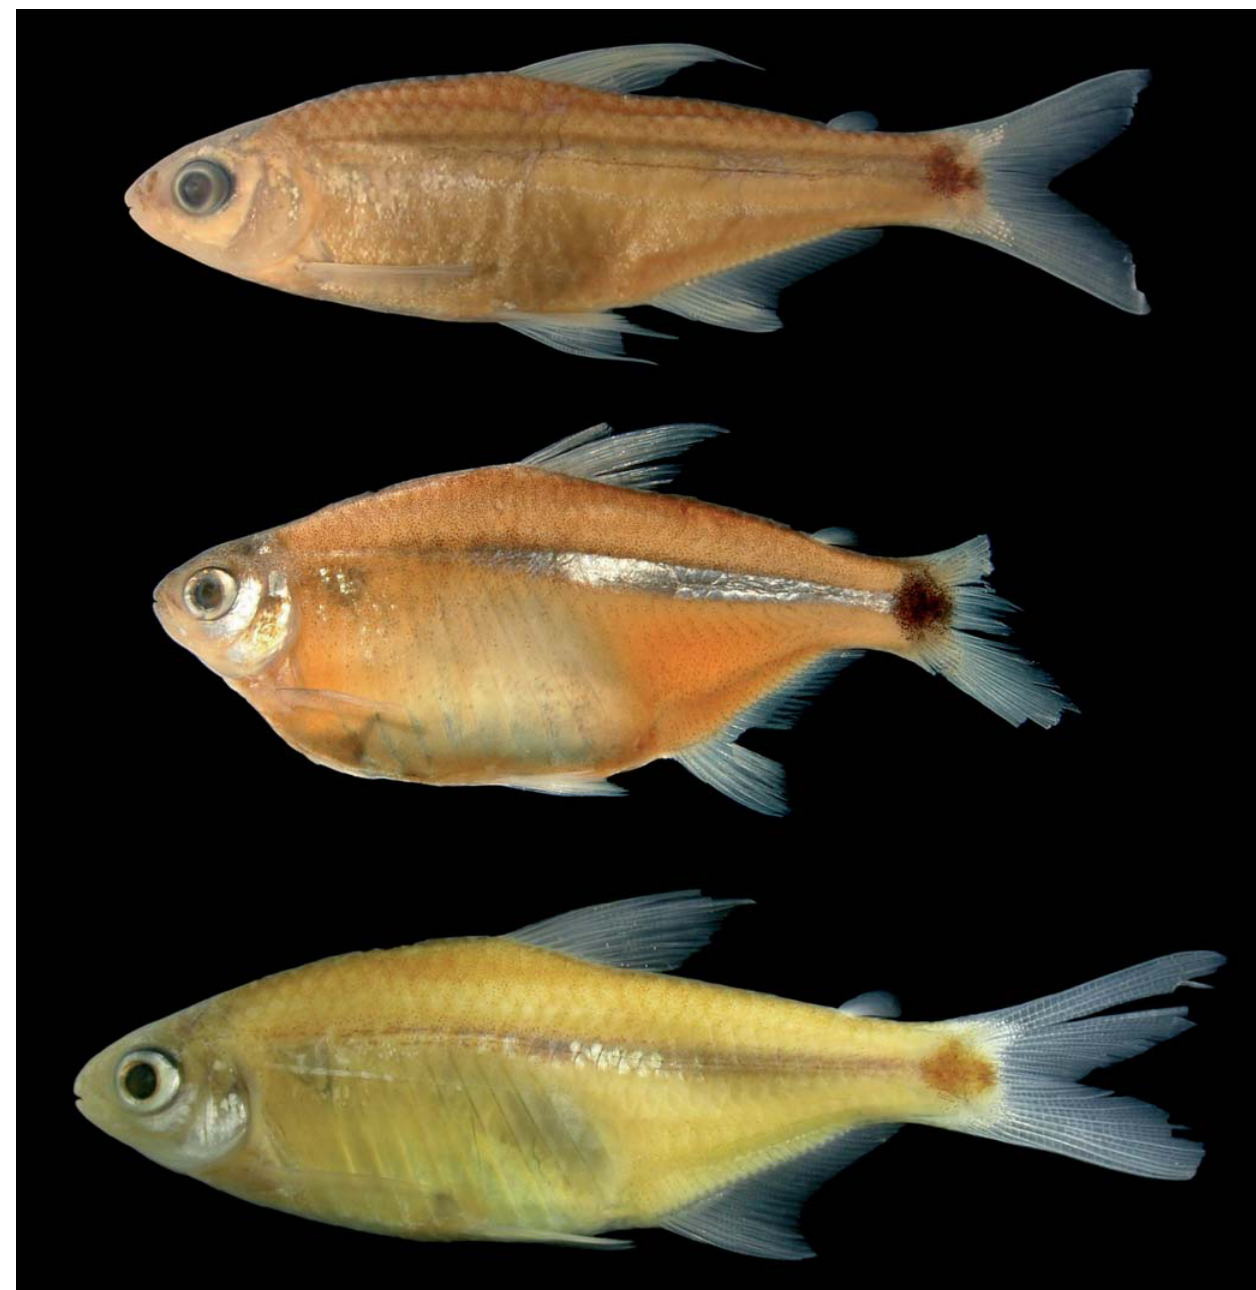
Fig. 14. Holotype of Odontostilbe ecuadorensis , ANSP 170608, male 45.7 mm SL (top), and paratypes MEPN 1517, 1 female 45.2 mm SL (middle) with exceptionally developed ovaries, ANSP 130574, female 46.6 mm SL